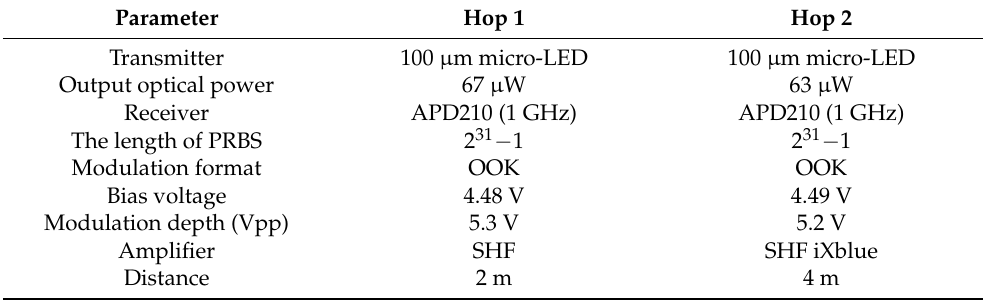
Table 1. Experimental parameters based on Hop 1 and Hop 2.